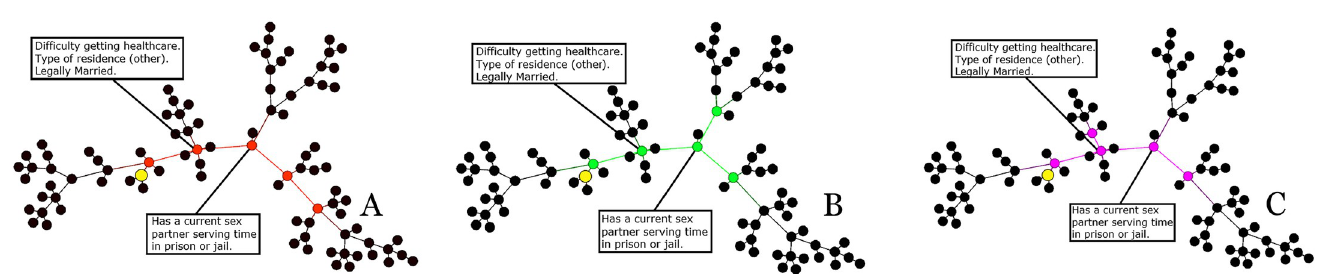
Fig 3. One component from the Los Angeles referral network, with nodes highlighted by centrality. A . Betweenness. B . Closeness. C . Eigenvector.